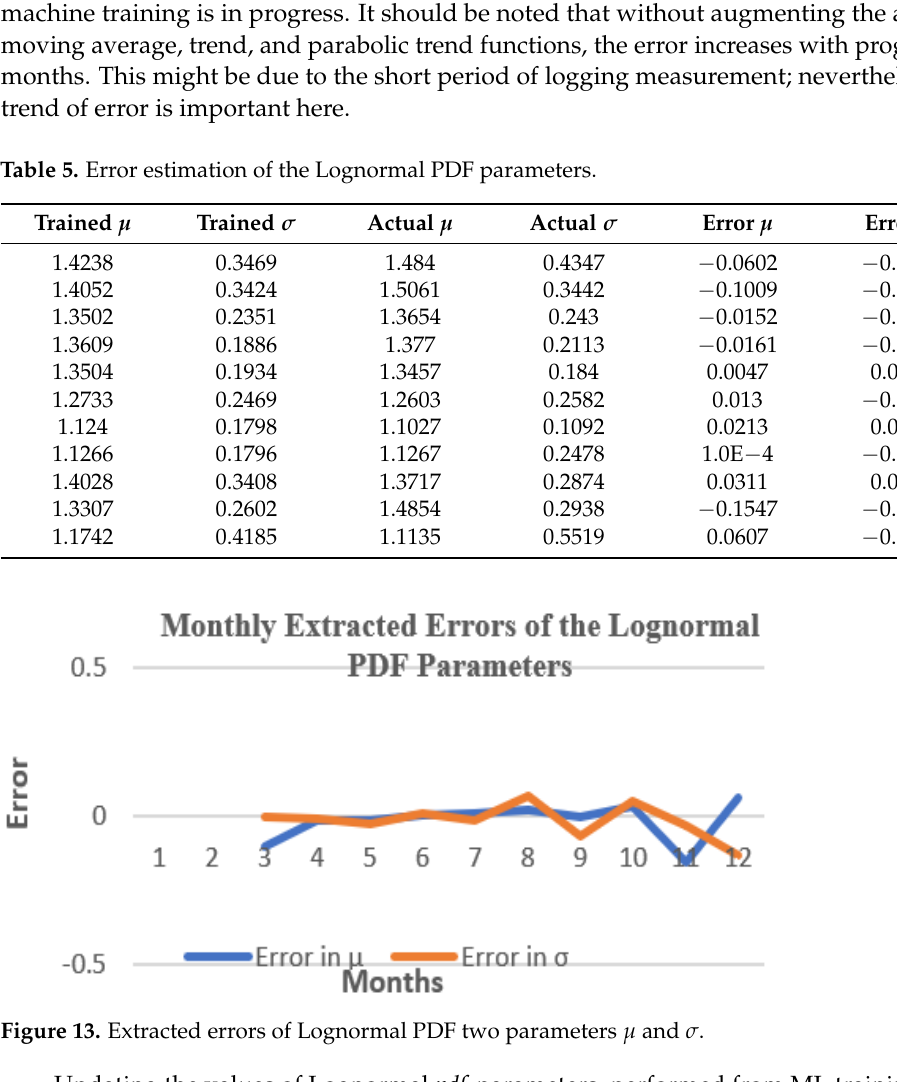
Table 5. Error estimation of the Lognormal PDF parameters.